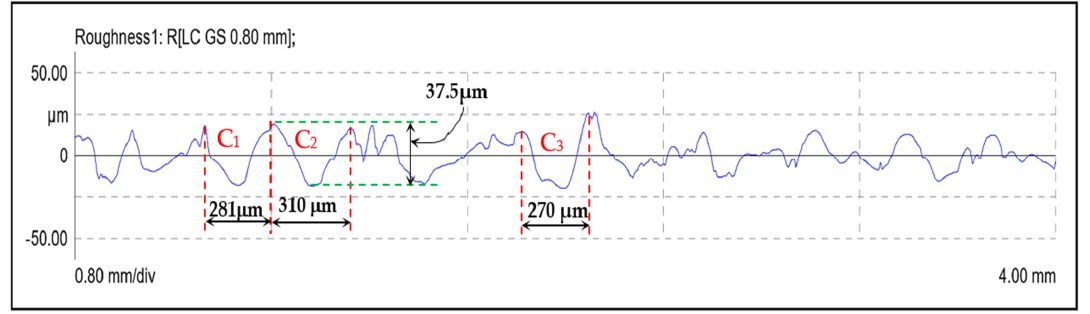
Figure 6. Simulated and experimentally formed carter geometry for Φ 90 nm at T d = 300 µ s, I p = 6 A, Vg= 80 V. The study on surface crack density (SCD) is carried using SEM micrographs taken at 500X magnification. The SCD is the ratio of total crack length to area of SEM micrograph and is evaluated using Equations (7) and (8).